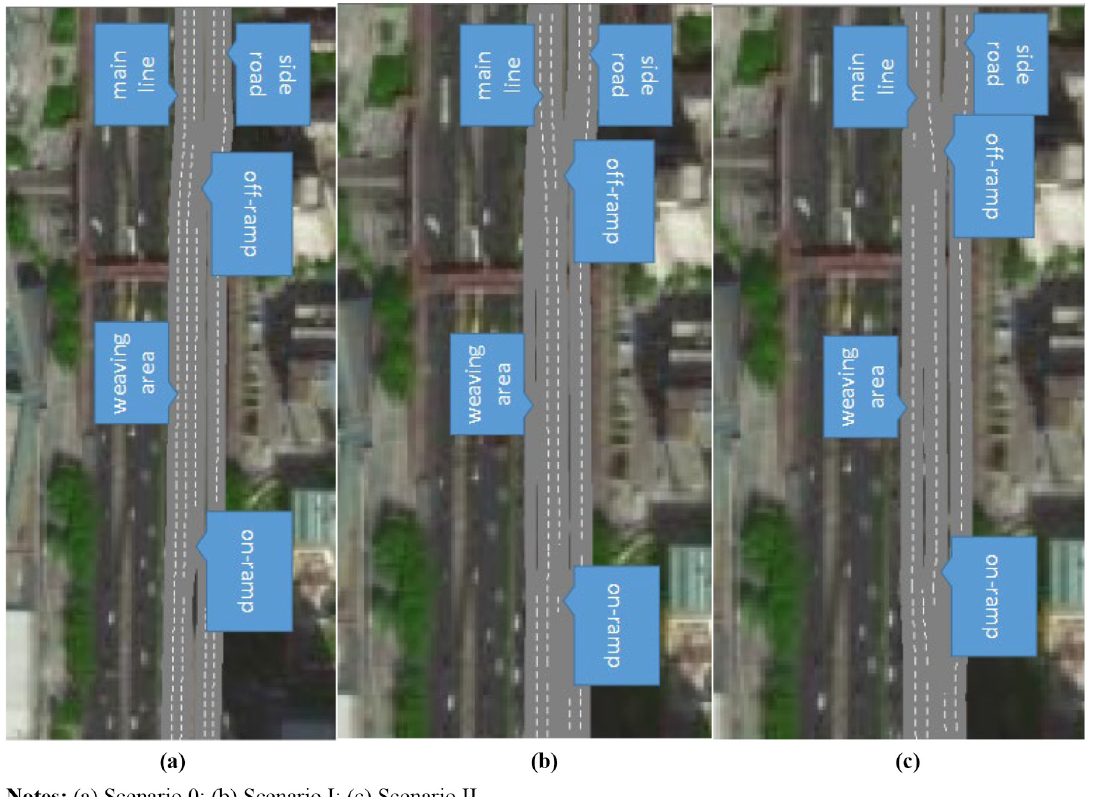
Figure 13 Traf fi c simulation in different scenarios